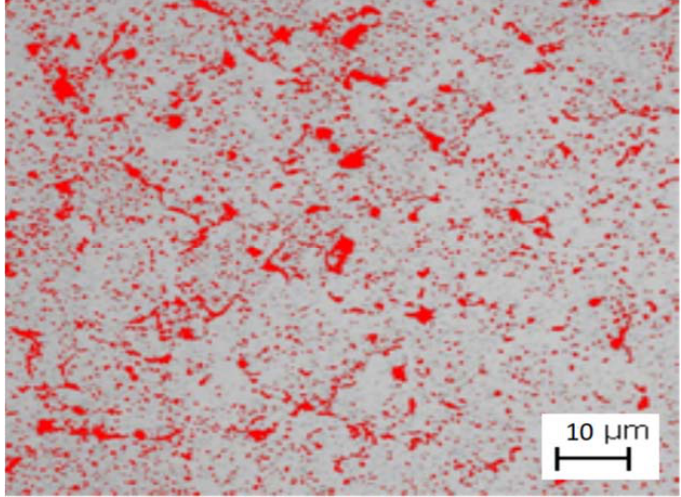
Figure 7. Sintered stainless–steel microstructure at 1250 °C for 1 h. Regions in red indicate porosity.